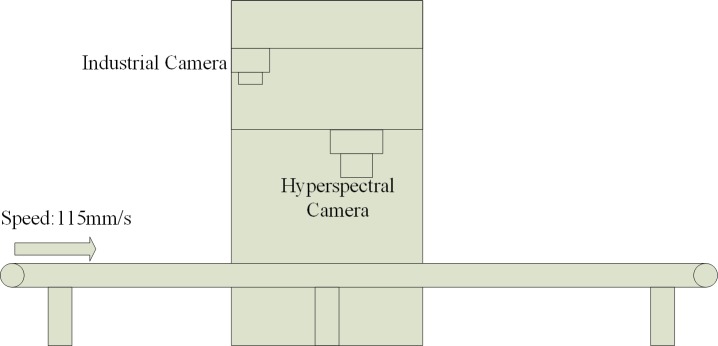
System’s structure.